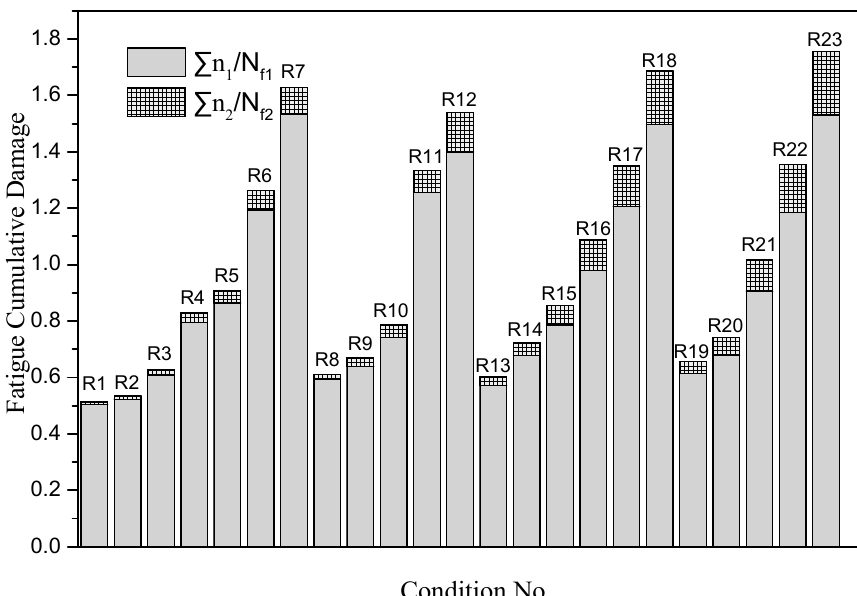
Figure 9. Damage accumulation of every condition.